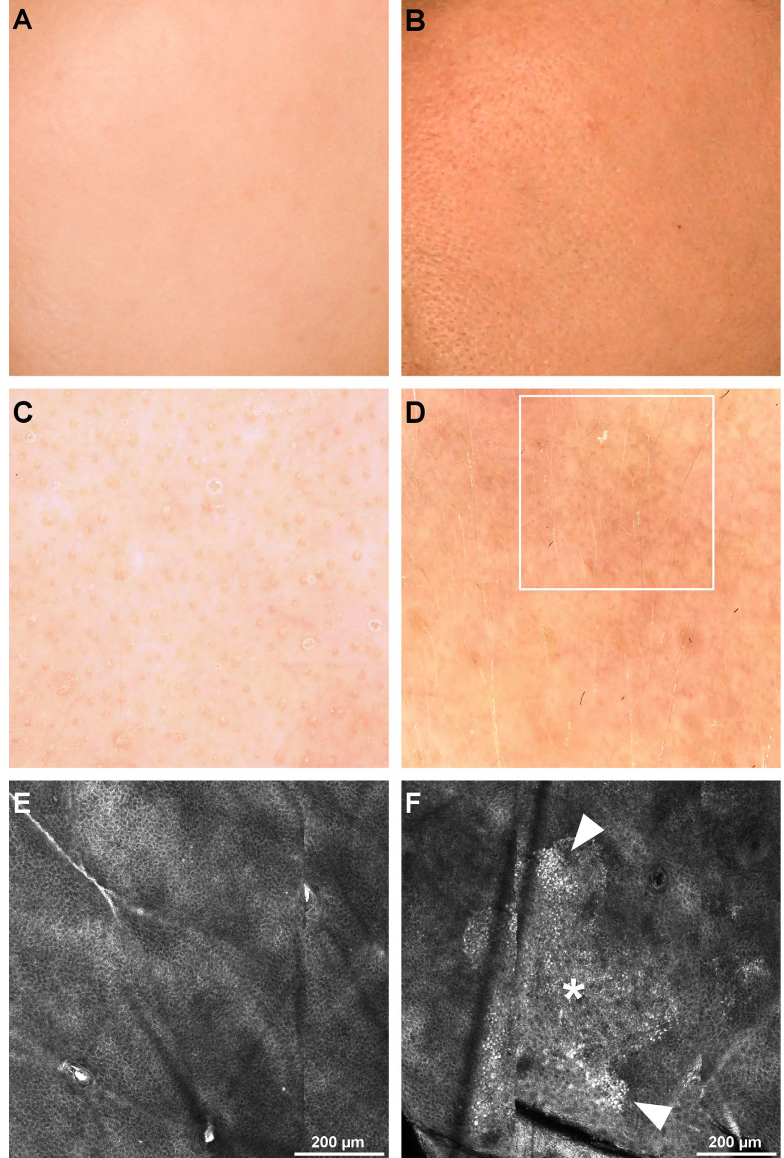
Figure 5. Clinical, dermoscopy, and confocal microscopy (RCM) images of honeycomb pattern with and without mottled pigmentation. ( A ). Clinical image of left cheek skin of a 32-year-old female. ( B ). Clinical image of left cheek skin of a 57-year-old female. ( C ). Dermoscopy image of the patient in panel A showing no signs of pigmentation. ( D ). Dermoscopy image of the patient in panel B revealing mottled pigmentation (white square). ( E ). RCM mosaic showing a regular honeycomb pattern without pigmentation in the 32-year-old female. ( F ). RCM mosaic displaying mottled pigmentation (white asterisk) with clusters of bright keratinocytes (white arrowheads) in the 57-year-old female. Polycyclic papillary rings were nearly absent in the first group of participants, with all subjects in group V having elongated and partially anastomosing structures